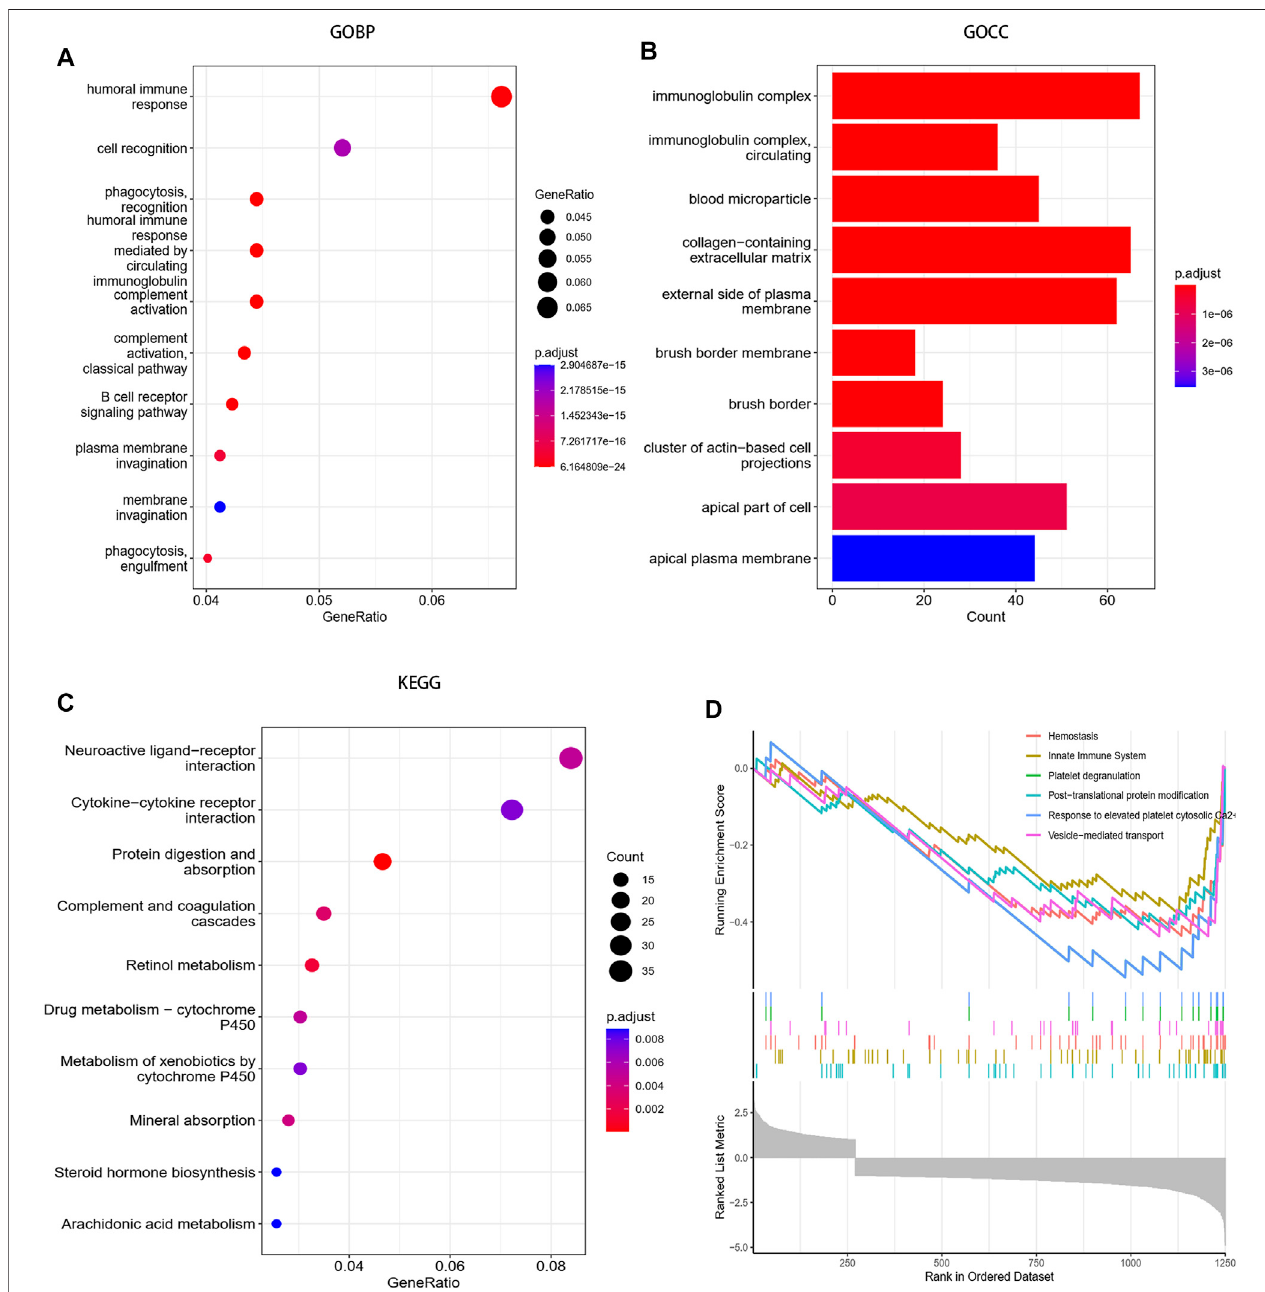
FIGURE3| Functionalenrichmentanalysisbetweenthehigh-riskgroupandthelow-riskgroup. (A) BiologicalprocessofGOanalysisbetweenthetwogroups. (B) Cellular component of GO analysis between the two groups. (C) KEGG analysis between the two groups. (D) Reactome pathway analysis between the two groups.